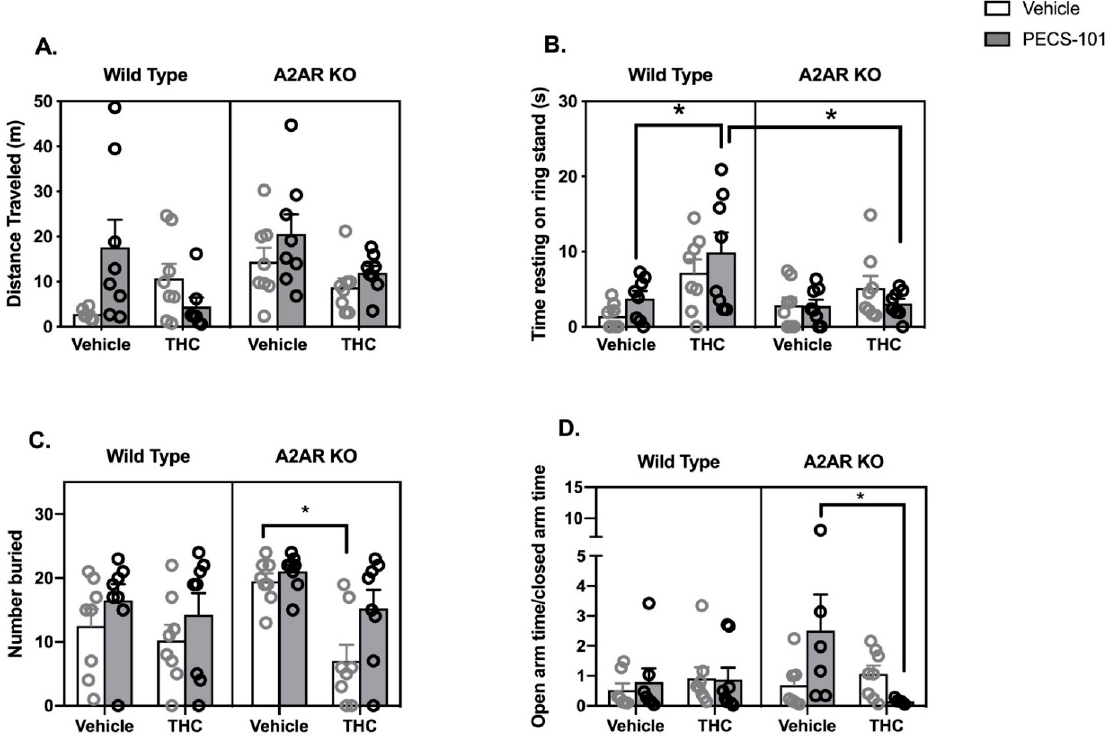
Figure 3. Behavioral effects of THC (5 mg/kg), PECS-101 (5 mg/kg) and their combination in wild type (WT, open bars and gray symbols) and A2AR null (A2AR-KO, closed bars and black symbols) mice. ( A ) Drug effects on distance moved in 15 min while in a cylindrical open field arena. Three outliers were identified (2 in the WT/veh/veh group and 1 in the WT/THC/PECS-101 group). ( B ) Drug effects on cataleptic behavior in the ring stand assay. ( C ) Drug effects on the number of marbles buried. ( D ) Drug effects on the ratio of time spent in the open and closed arms of the EPM. A total of 8 mice were eliminated from this data set; three mice froze on the open arm of the maze (2 in the KO/veh/PECS-101 group and 1 in the KO/THC/PECS-101 group) and five mice were statistical outliers (one each in the WT/veh/veh, WT/veh/PECS-101 and KO/veh/veh groups; and 2 in the KO/THC/PECS-101 group). Bars represent the mean, and vertical lines are the stand- ard error of the mean. * p < 0.05. 3. Discussion The first goal of the study was to determine whether six behavioral effects commonly seen with CB1R agonist treatment (reduced spontaneous movement, catalepsy, hypother- mia, antinociceptive reflex inhibition, marble burying and behavior in the elevated plus maze) were altered in mice with genetic deletion of the A2A subtype of adenosine recep- tor. We examined a range of THC doses in each of the assays, and the only assay in which a significant interaction between THC treatment and genotype occurred was catalepsy. THC produced significantly less catalepsy in the A2AR-KO mice than WT, suggesting that signaling through the A2AR is required for the full cataleptic effect of THC. Catalepsy has long been recognized as a cardinal behavioral sign of THC intoxication in rodents [19]. The cataleptic effect of cannabinoid agonists is characterized by immobil- ity when placed in a position that would normally evoke immediate movement. It is not that animals are unable to move, but rather that they are in a trance-like state. It has been suggested that THC-induced catalepsy is responsible for motor vehicle accidents in can- nabis-intoxicated individuals [20]. The cataleptic effects of THC and other CB1R agonists are completely dependent on the expression of the CB1 subtype of the cannabinoid recep- tor [21]. Cell type-specific CB1R deletion strategies [21] and rescue studies in which CB1R are added back to specific neuronal subtypes in otherwise CB1R-null mice [22] both indi- cate that CB1R expression in D1 dopamine receptor-expressing medium spiny neurons